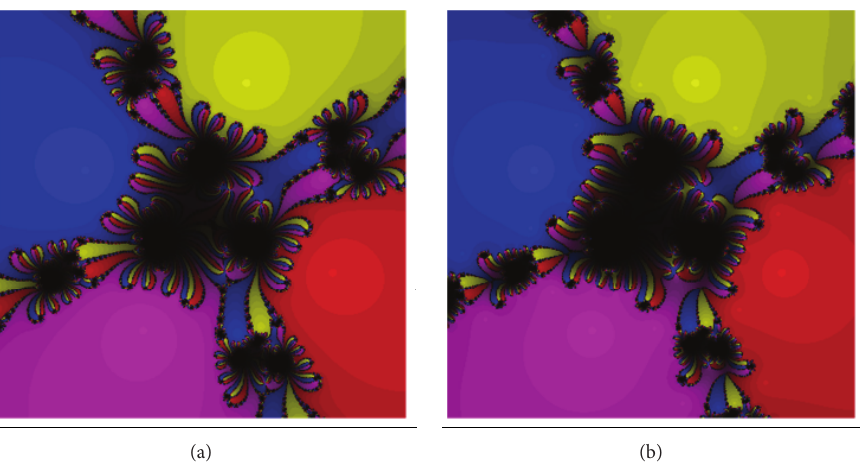
Figure 4: The methods (6) (a) and (14) (b) for Test Problem 2.